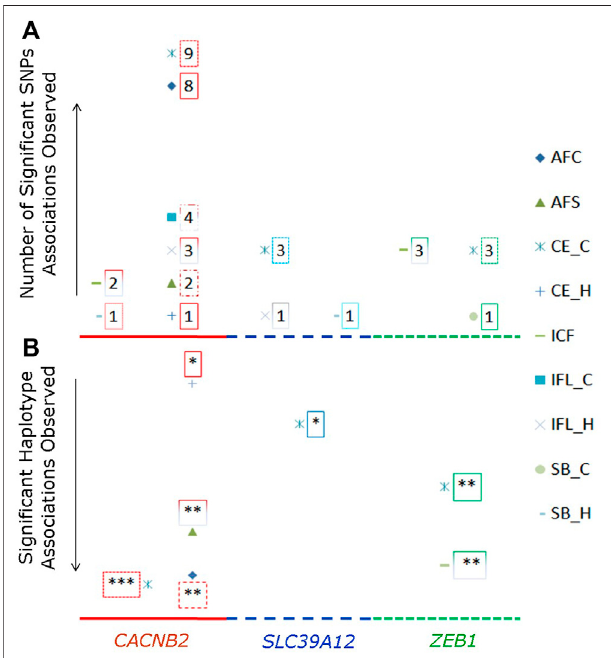
FIGURE 2 | Number of SNPs (A) or haplotype blocks (B) that were signi fi cantly associated with reproductive traits in gene CACNB2 , SLC39A12 and ZEB1 .Thelegendsforninereproductivetraitsareshownontherightside. In graph “ B ” , the “ * ” represents the signi fi cant association on the level of p < 0.05, “ ** ” represents p < 0.01, and “ *** ” represents p <